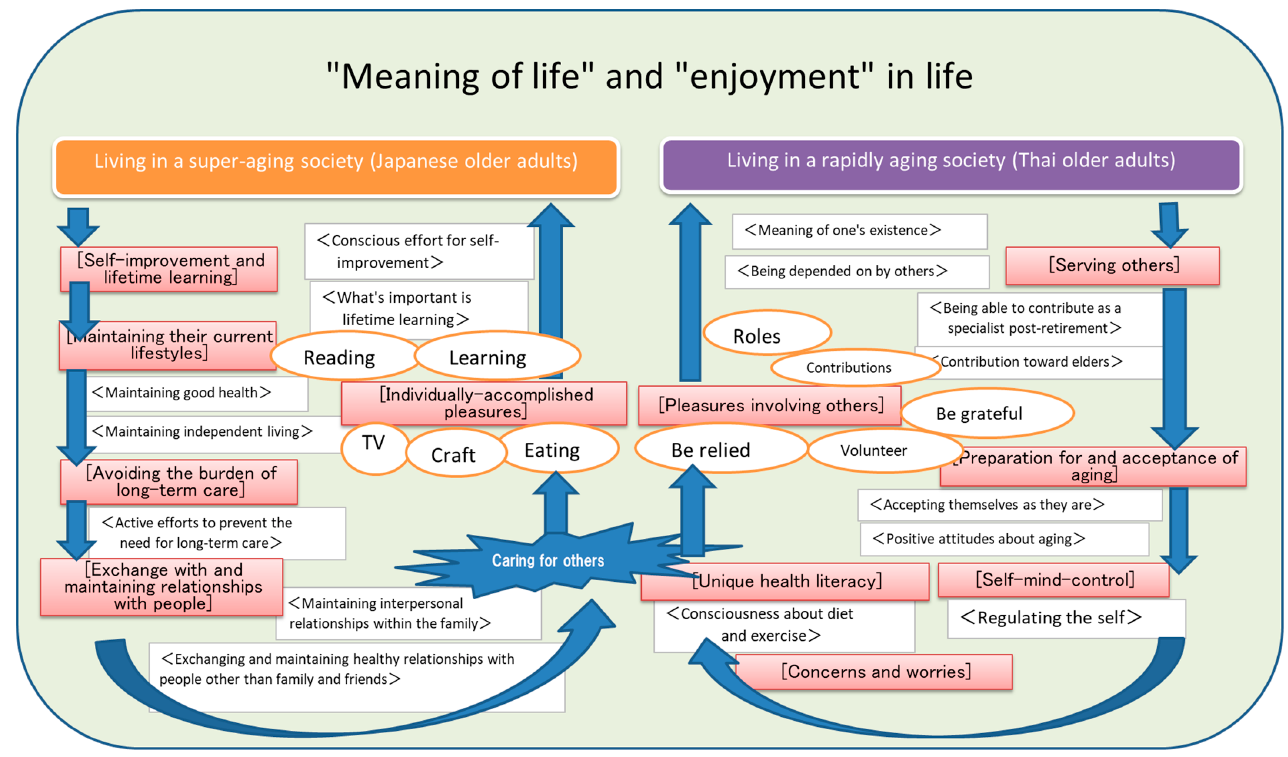
Figure 1. Illustration of a storyline using conceptualized categories and subcategories.